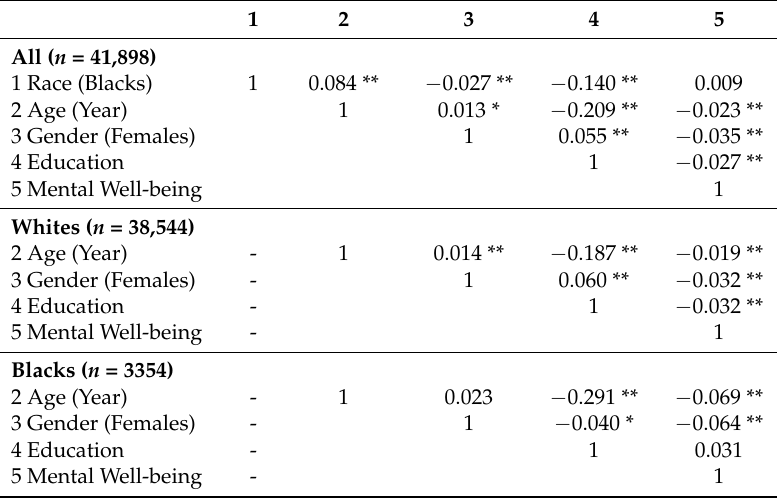
Table 2. Correlation matrix in the pooled sample and by